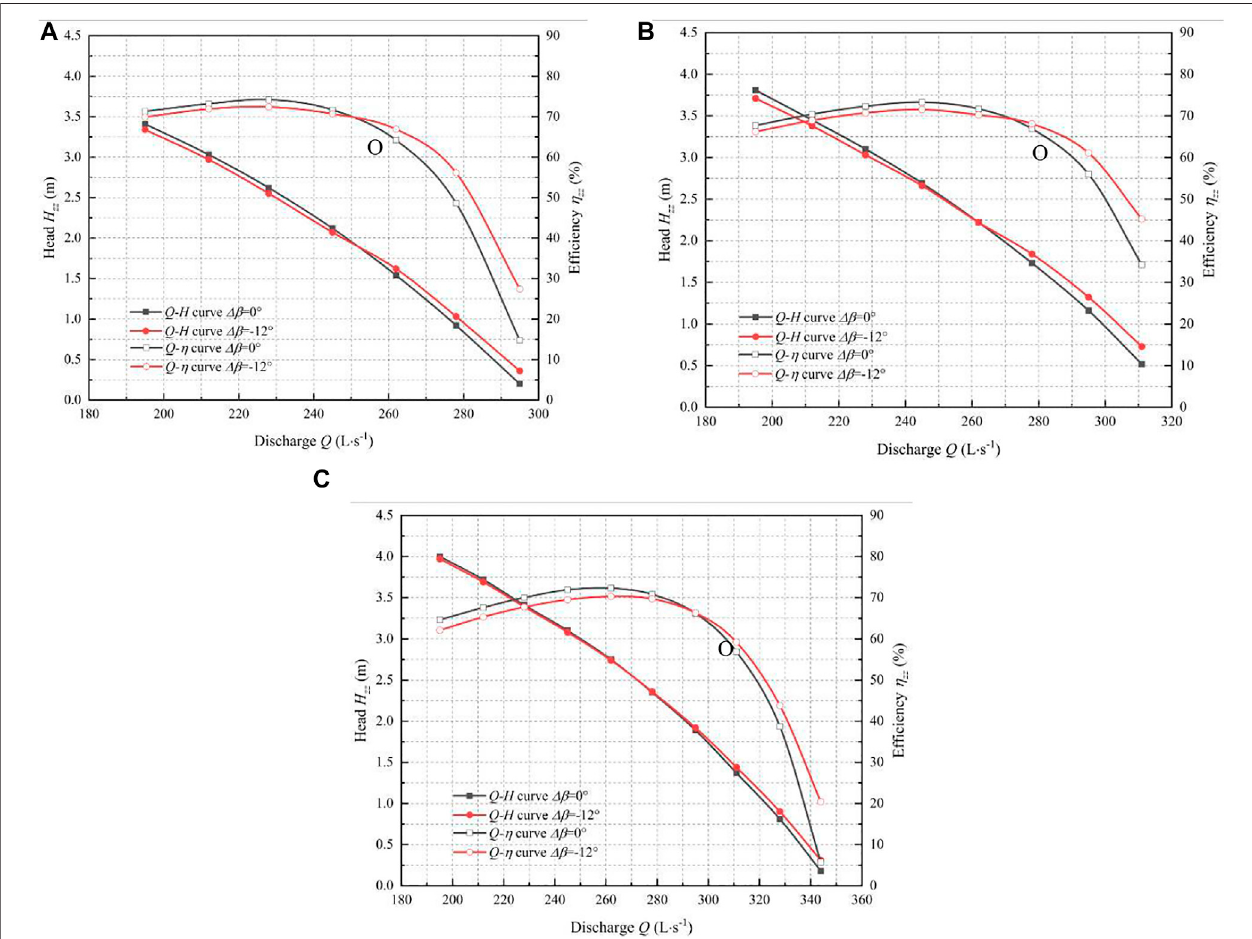
FIGURE12| Numerical calculationresultsof Q ~ H zz and Q ~ η zz relationshipcurvesoftheaxial fl owpumpdevicewith Δ β of0 ° and − 12 ° ,respectively. (A) α = − 4 ° , (B) α = − 2 ° , (C) α = 0 ° .